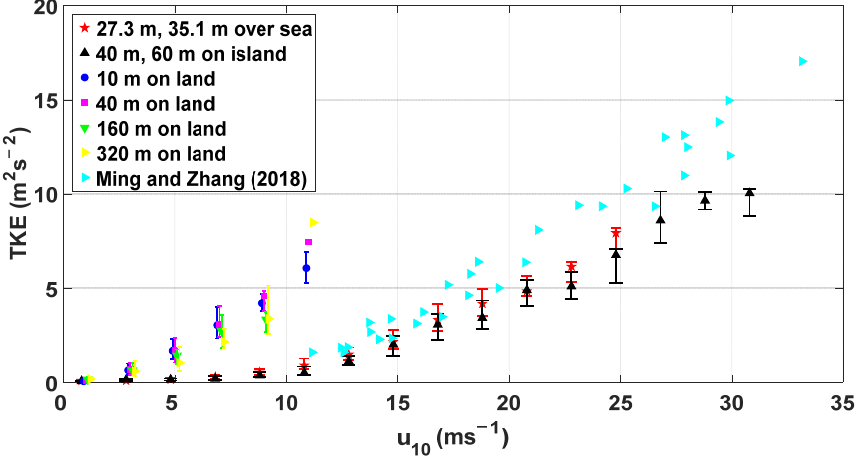
Figure 9. The same as Figure 8 except for the turbulent kinetic energy ( 𝑇𝐾𝐸 ) as a function of 𝑢 (cid:2869)(cid:2868) . Dissipative heating ( 𝐷𝐻 ) is an important source of energy for typhoon development and intensification [21]. Most of the energy is dissipated through the molecular process in the air–sea (air–land) interaction, while a small part of the energy is returned to the at- mosphere through dissipative heating. Figure 10 shows 𝐷𝐻 as a function of 𝑢 (cid:2869)(cid:2868) . Figure 10 depicts that the 𝐷𝐻 increases with 𝑢 (cid:2869)(cid:2868) in much the same manner as the turbulent ki- netic energy ( 𝑇𝐾𝐸 ). The values of 𝐷𝐻 increase with increasing 𝑢 (cid:2869)(cid:2868) and those on land are much larger than those over sea (island). The values of 𝐷𝐻 at the heights of 160 m and 320 m are obviously larger than those at the heights of 10 m and 40 m on land. Figure 10 shows that 𝐷𝐻 is up to 40 W m − 2 over sea (island) when 𝑢 (cid:2869)(cid:2868) ≈ 30 m s − 1 and 𝐷𝐻 is up to 30 W m − 2 on land when 𝑢 (cid:2869)(cid:2868) ≈ 10 m s − 1 . The result over sea is actually consistent with pre- vious studies [30]. Similar to 𝑢 ∗ and 𝑇𝐾𝐸 , the measurements of 𝐷𝐻 on the Donghai is- land are higher (lower) than those over sea (on land). This shows that the 𝐷𝐻 is higher on rougher surfaces.